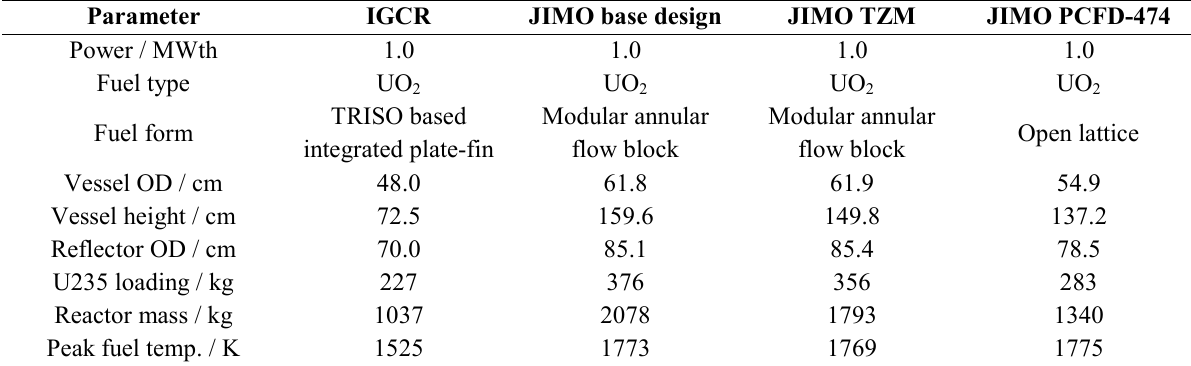
Table IV. Comparison of key parameters of different